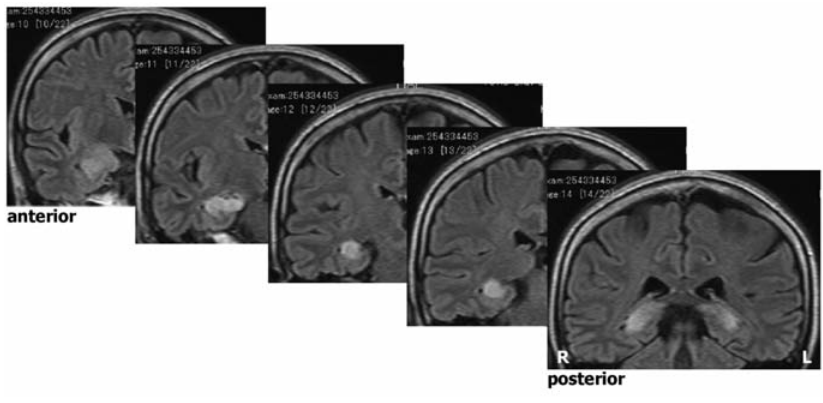
Figure 1. Brain magnetic resonance imaging of the patient. Bilateral, symmetrical high signal lesions localized in the body to the infundibulum of the hippocampus, which slightly extended to the parahippocampal gyrus and the amygdala on fluid attenuated inversion recovery (FLAIR) images. Coronal images are shown. Pre-existing mild malfor- mation in the temporal neocortex was also